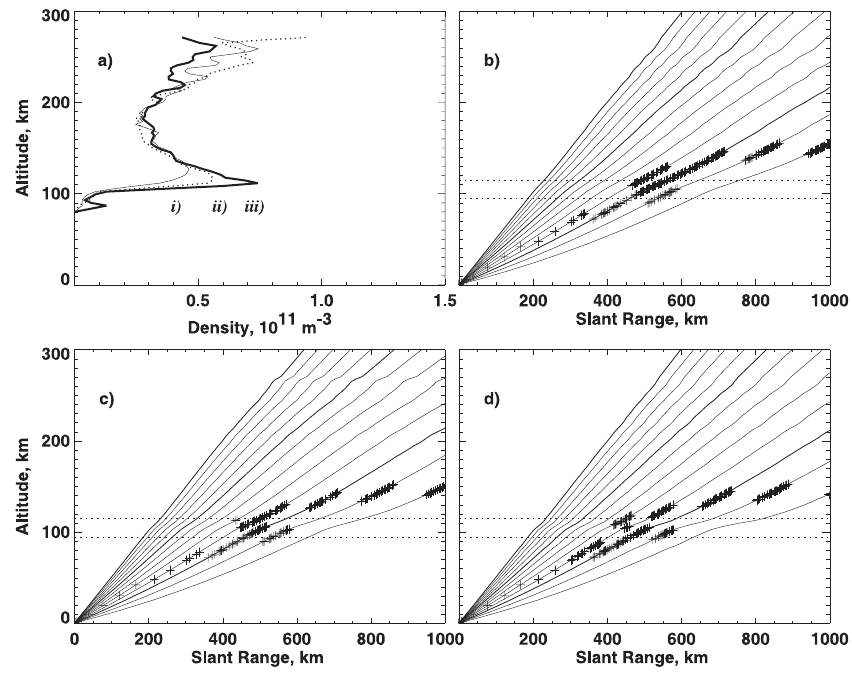
Fig. 13. (a) Three electron density pro- files measured by EISCAT at 14:50UT (case (i)), 14:10UT (case (ii)) and 14:30UT (case (iii)) and (b) − (d) possi- ble ray paths for 12.4-MHz radar waves at Hankasalmi, Finland. The ray paths are shown in elevation angle step of 2 ◦ for the elevations between 6 ◦ and 30 ◦ . Crosses indicate ranges where the as- pect angle of the ray with the Earth’s magnetic flux line is less than 1 ◦ . Hor- izontal dotted lines indicate the elec- trojet irregularity layer between 95 and